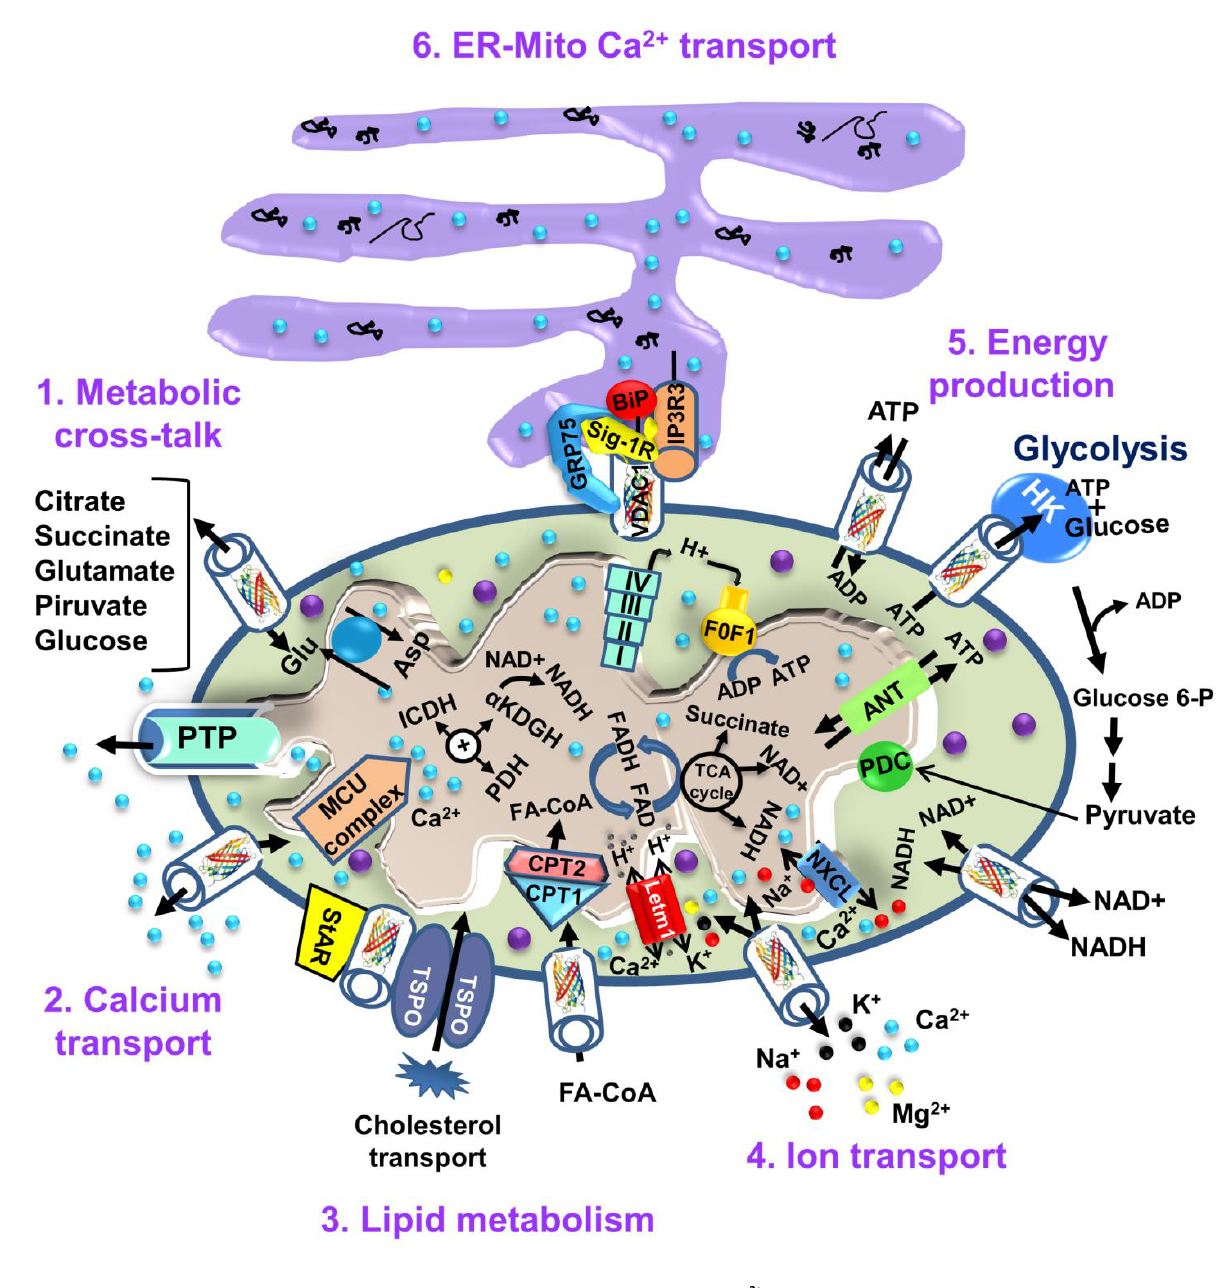
FIGURE 2: VDAC1 as a multi-functional channel involved in metabolite, cholesterol and Ca 2+ transport, energy production and in ER-mitochondria struc- tural and functional association. The functions of VDAC1 in cell life include control of the metabolic cross-talk between the mitochondria and the rest of the cell energy production, regulation of glycolysis via binding of HK, Ca 2+ signaling and cholesterol transport. The various functions of VDAC1 in the cell and mitochondria functions are presented. These include: 1 . Control of the metabolic cross-talk between mitochondria and the rest of the cell; 2 . Transport of Ca 2+ to and from the IMS and acting in Ca 2+ signaling; 3. Lipid metabolism; 4 . Transport of ions, such as Mg 2+ , Zn + , Na + and K + ; 5 . Mediating cellular energy production by transporting ATP/ADP and NAD + /NADH and acyl-CoA (FA-CoA) from the cytosol to and from the IMS, and regulating glycolysis via association with HK; 6 . Structurally and functionally contributing to ER-mitochondria contacts, mediating Ca 2+ transport from the ER to mitochondria. Ca 2+ influx and efflux systems in the IMM are shown. The mitochondrial Ca 2 ‏ + uniporter (MCU), in association with a calcium-sensing accessory subunit (MCU1), mediates Ca 2+ transport from the IMS into the matrix. The ryanodine receptor (RyR) in the IMM mediates Ca 2+ influx. NCLX, a Na + /Ca 2+ exchanger, mediates Ca 2+ efflux from the matrix to the IMS. High levels of matrix Ca 2 ‏ + trigger the opening of the PTP, a fast Ca 2+ release channel. Molecular fluxes are indicated by arrows. The function of Ca 2+ in regulating energy production is mediated via activation of the TCA cycle enzymes pyruvate dehydrogenase (PDH), isocitrate dehydro- genase (ICDH) and α-ketoglutarate dehydrogenase (α-KGDH), leading to enhanced activity of the TCA cycle. The electron transport chain (ETC) and the ATP synthase (F o F 1 ) are also presented. VDAC1 mediates the transfer of acyl-CoAs across the OMM to the IMS, where they are converted into acylcarnitine by CPT1a for further processing by β-oxidation. VDAC1 is involved in cholesterol transport by being a constituent of a multi-protein complex, the transduceo- some, containing StAR/TSPO/VDAC1.The ER-mitochondria association is presented with key proteins indicated. These include the inositol 3 phosphate recep- tor type 3 (IP 3 R3), the sigma 1 receptor (Sig1R) (a reticular chaperone), binding immunoglobulin protein (BiP), the ER HSP70 chaperone, and glucose- regulated protein 75 (GRP75). IP 3 activates IP 3 R in the ER to release Ca 2+ that is directly transferred to the mitochondria via